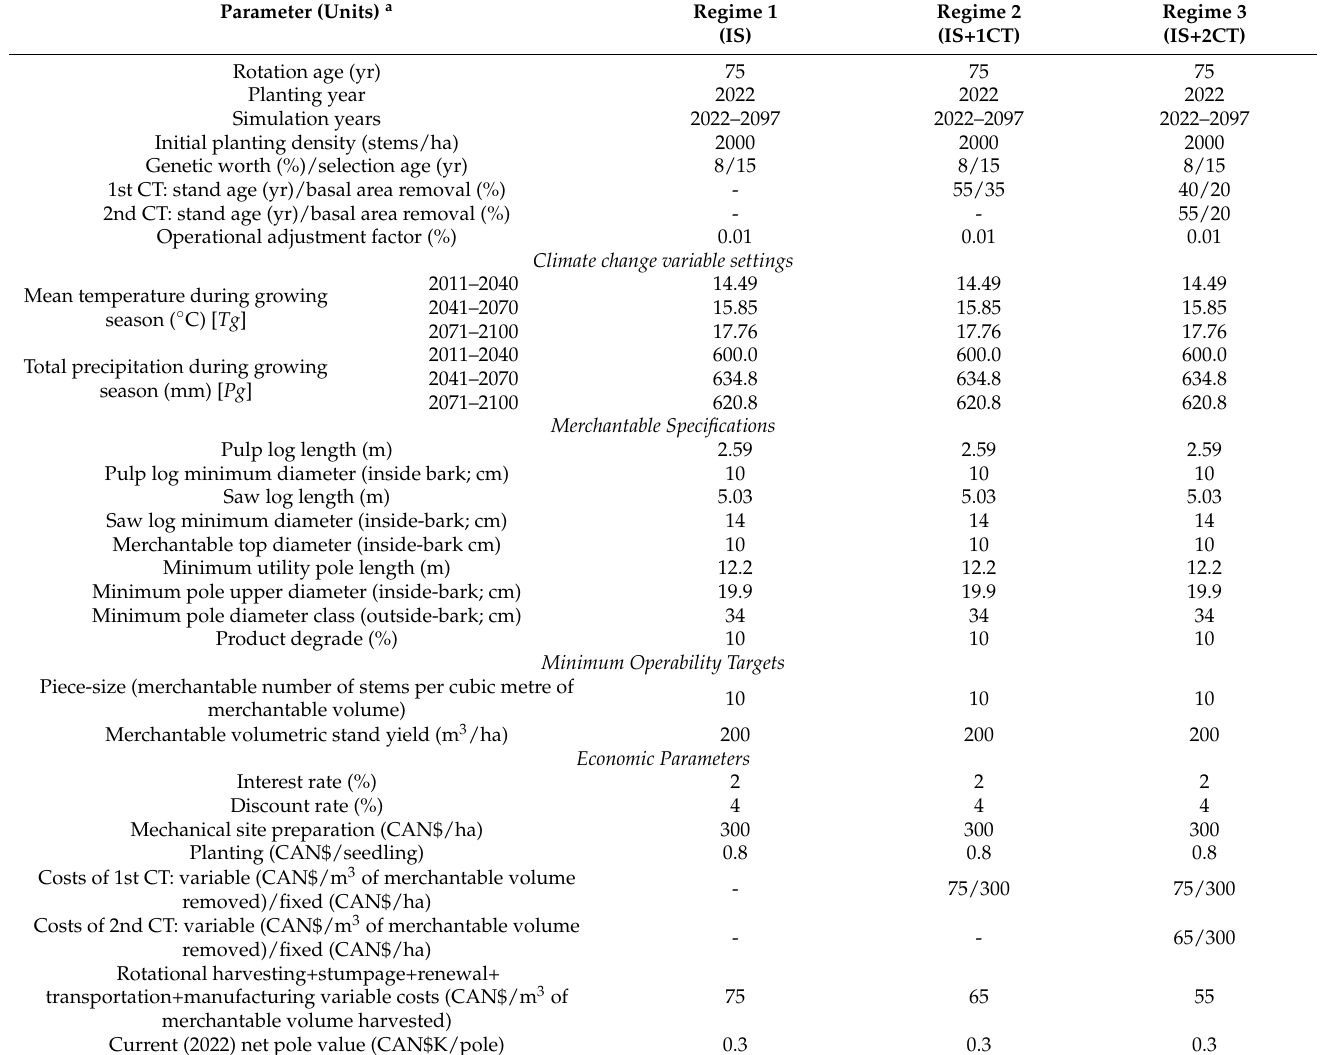
Table 1. Input parameters for the SSDMM software simulations for red pine plantations growing on medium-to-good quality sites under a RCP8.5 climate change scenario at Thessalon,